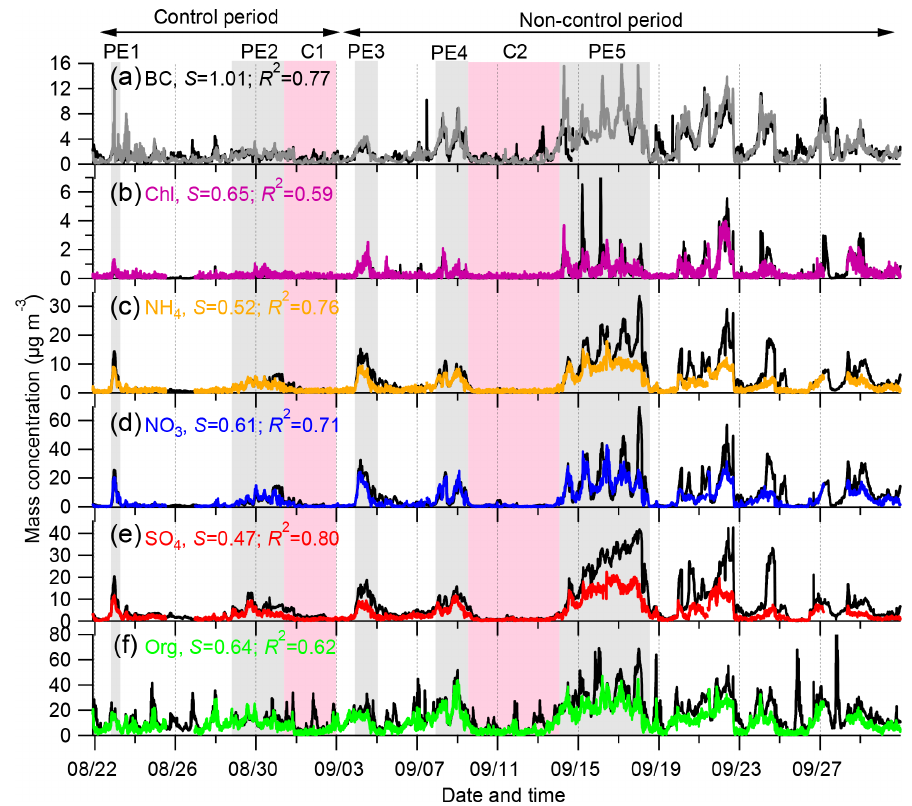
Figure 6. Comparisons of the time series of aerosol species between the ground site (black lines) and 260m (colored lines). Five pollution episodes (PE1, PE2, PE3, PE4 and PE5) and two clean periods (C1 and C2) are marked for further discussions.